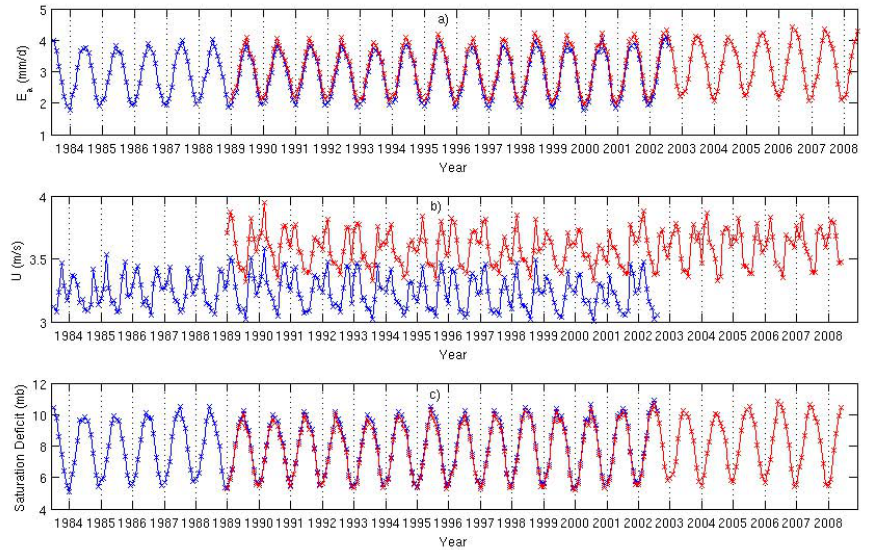
Fig. 3. Global means of: (a) bulk aerodynamic evaporation E a (in mmday − 1 ) calculated from input data by ERA-40 (blue line) and ERA Interim (red line). (b) 10m wind speed U (in ms − 1 ) by ERA-40 (blue line) and ERA Interim (red line). (c) VPD (in mb) by ERA-40 (blue line) and ERA Interim (red